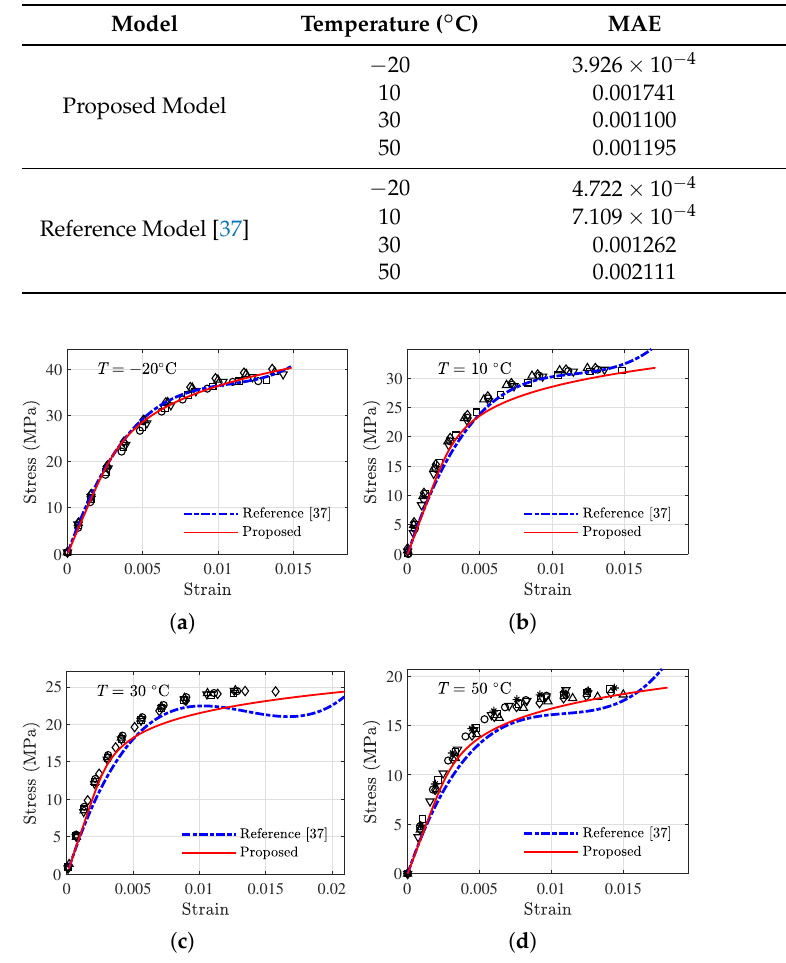
Figure 17. Comparison of the viscoelastic model and the proposed model at validation temperatures under compression. The discrete markers represent testing data. ( a ) − 20 ◦ C, ( b ) 10 ◦ C, ( c ) 30 ◦ C, and ( d ) 50 ◦